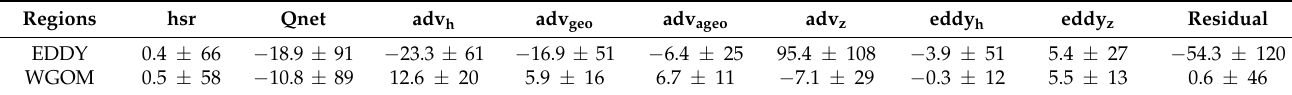
Table 2. Mean ± std of ocean heat budget terms (hsr = Qnet + adv h + adv z + eddy h + eddy z + residual in Equation (2)) for the 0–150 m layers averaged over an eddy-active region (EDDY in short) where the observed surface eddy kinetic energy is larger than 200 cm 2 s − 2 based on surface AVISO data, which is illustrated in a region enclosed by bold black curves in Figure 2, and over the western GOM (WGOM in short) (98 ◦ W–88 ◦ W,18 ◦ N–30 ◦ N). Only the heat terms in the region where waters are shallower than 150 m are computed. Note that adv h = adv geo + adv ageo . (Units: W m − 2 ) Abbreviations: hsr: heat storage rate; Qnet: net surface heat flux; adv h : horizontal heat advection by seasonal mean current; adv z : vertical heat advection by seasonal mean current; adv geo :